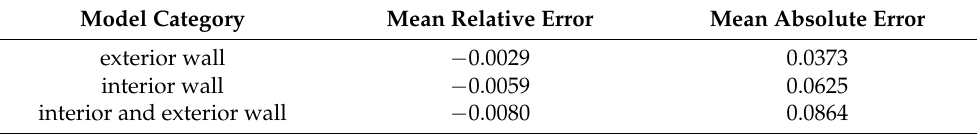
Table 4. Error analysis table of the three models. Model